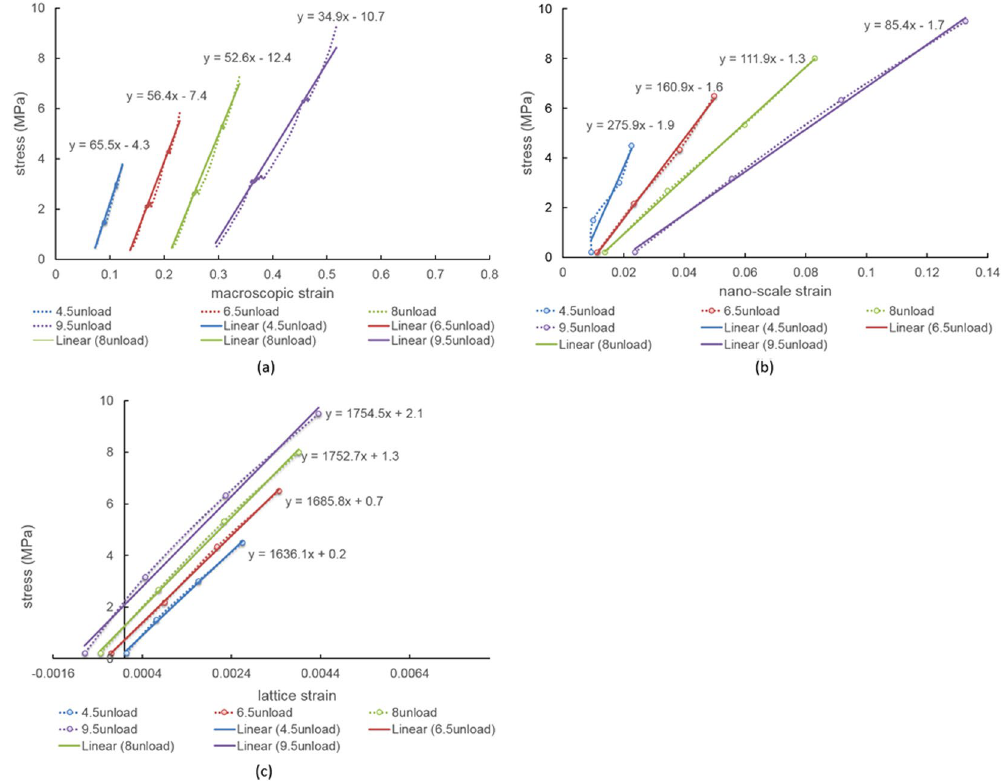
Figure 3. Softening behavior during cycles at different length scales. Macroscopic strain evolution of (a) unloading for each cycle; nano-scale strain evolution of (b) unloading for each cycle; atomic strain evolution (from peak 2) of (c) unloading for each cycle.